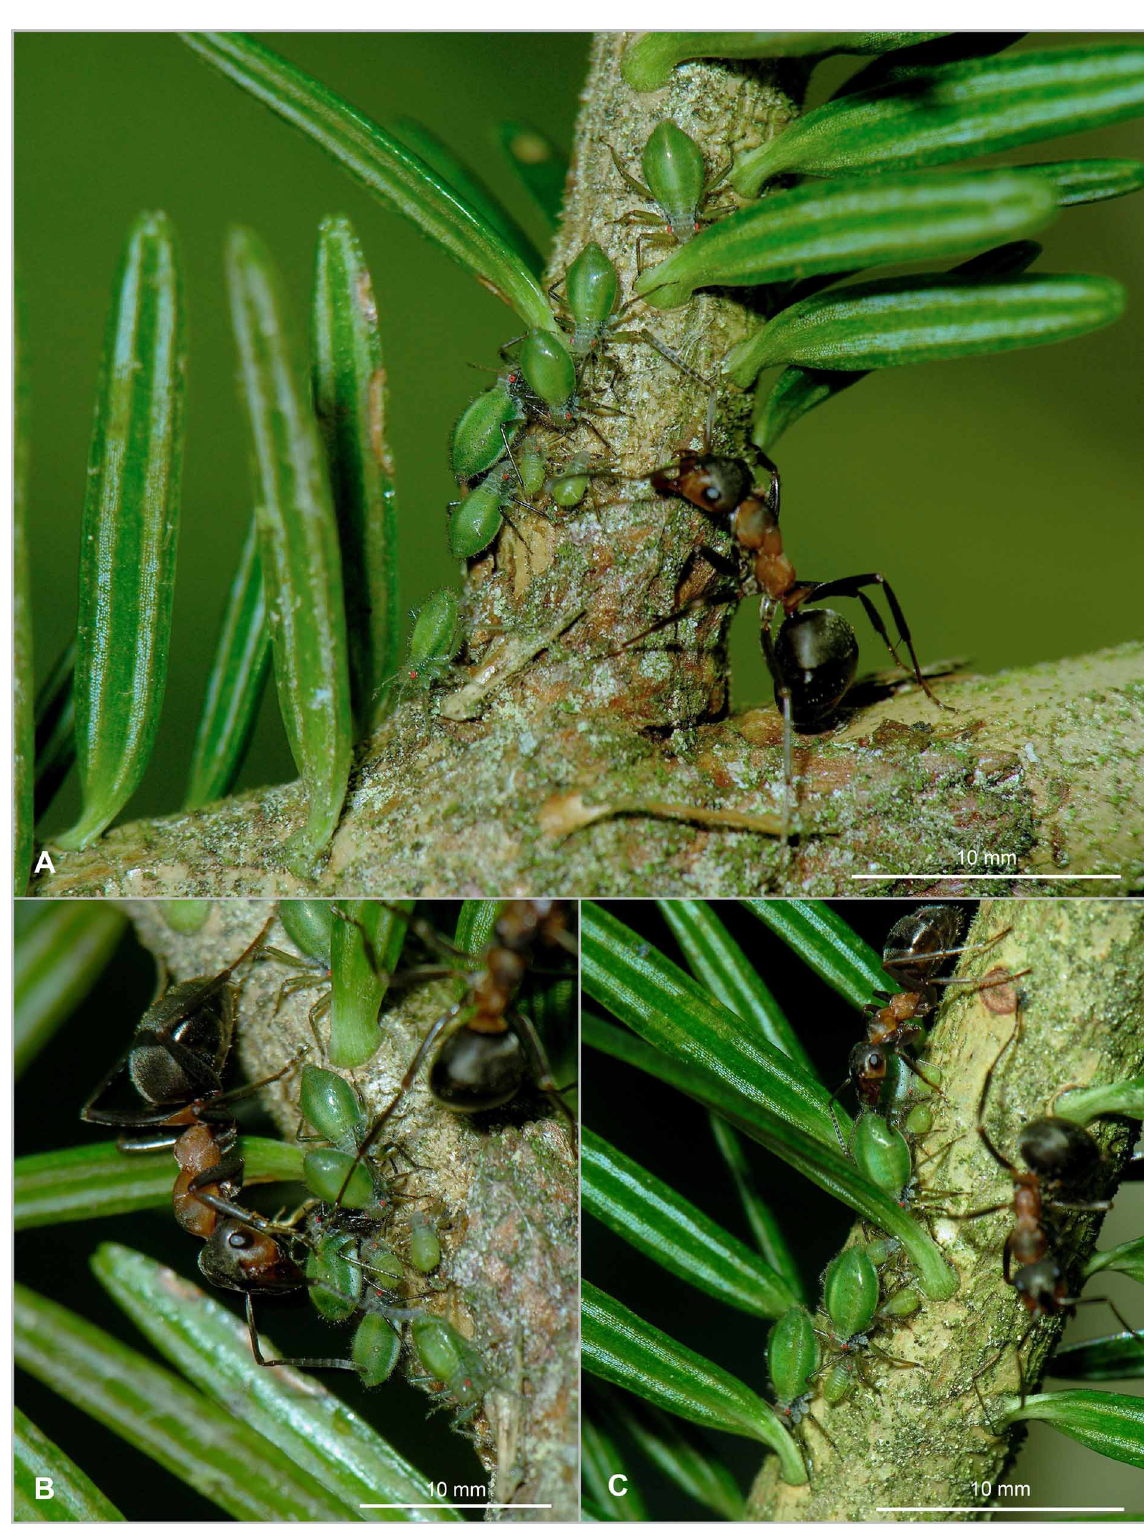
Fig. 54. Cinara (Cinara) pectinatae Nördlinger, 1880. Colonies (ad. and juv.) on trunk and branches of young Abies alba , attended by Formica polyctena Förster,